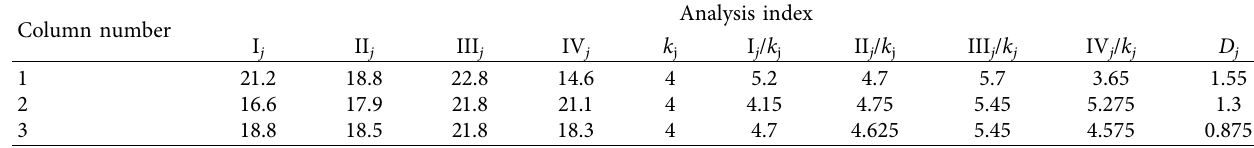
Table 5: Range analysis of orthogonal